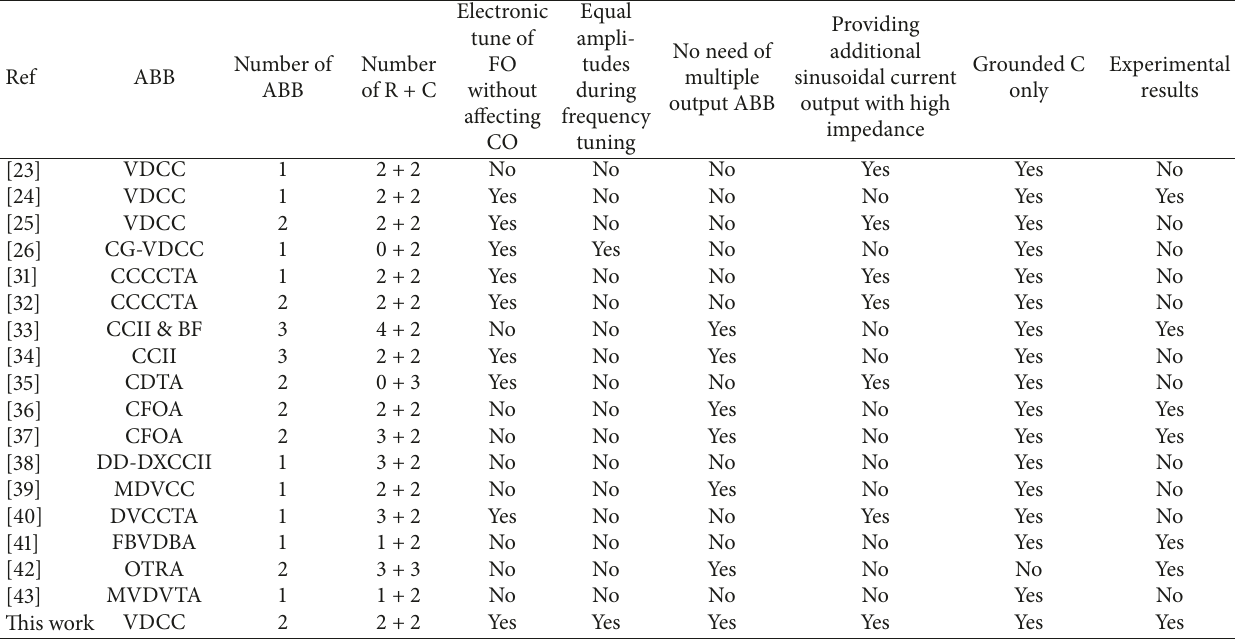
Table 1: Comparison results of this work and recent